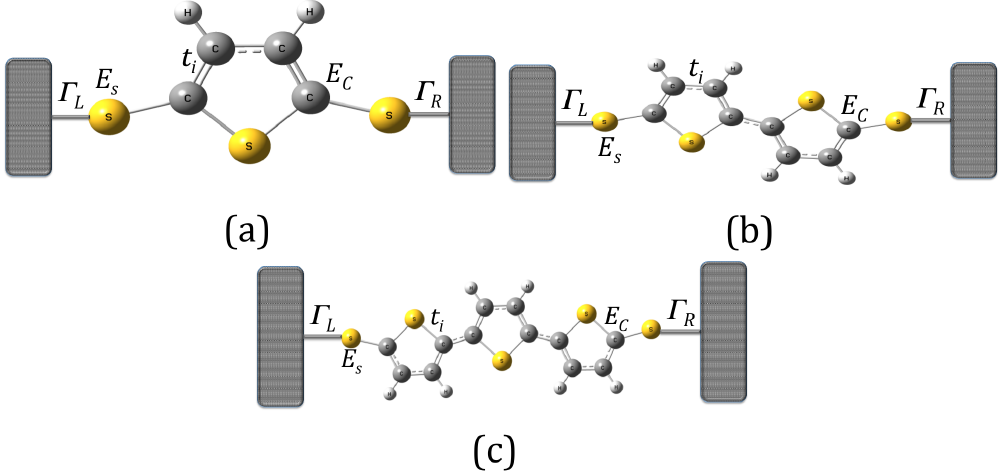
Figure 1. (color online) Molecular models with thiophene rings: ( a ) with one ring (model 1); ( b ) with two rings (model 2); and ( c ) with three rings (model